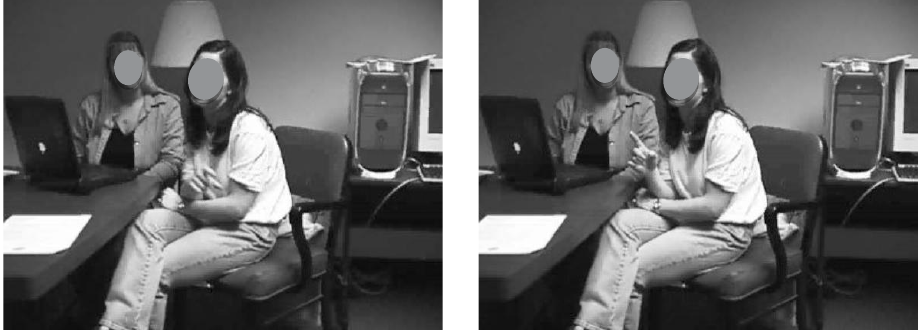
Figure 2 . An example of a single-handed